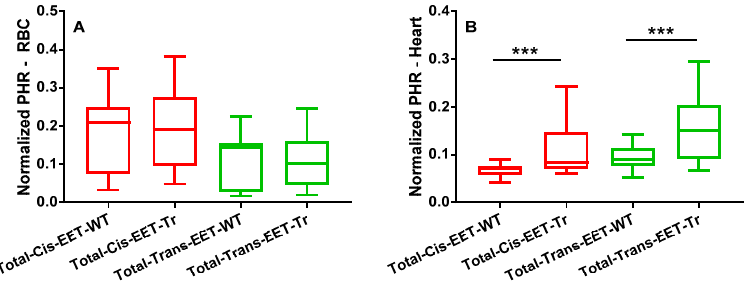
Figure 1. Total cis- and trans- epoxyeicosatrienoic acids (EETs) extracted from ( A ) erythrocyte membrane and ( B ) cardiac tissue of wild-type (WT) mice (N = 25, 18 female and seven male, *** p ≤ 0.001) and cardiomyocyte-specific overexpressing Cytochrome P450 2J2 (CYP2J2) transgenic (Tr) mice (N = 25, 16 female and nine male, *** p ≤ 0.001).